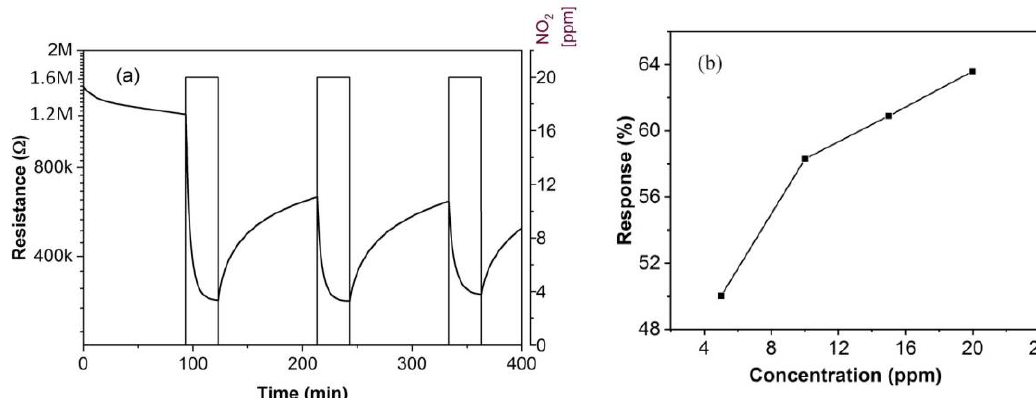
Figure 10. ( a ) Variation of resistance a multilayer rGO / CuO structure 6LbL vs. time at room temperature in interaction with 20 ppm NO 2 pules and ( b ) change of this response with increasing NO 2 gas concentration.